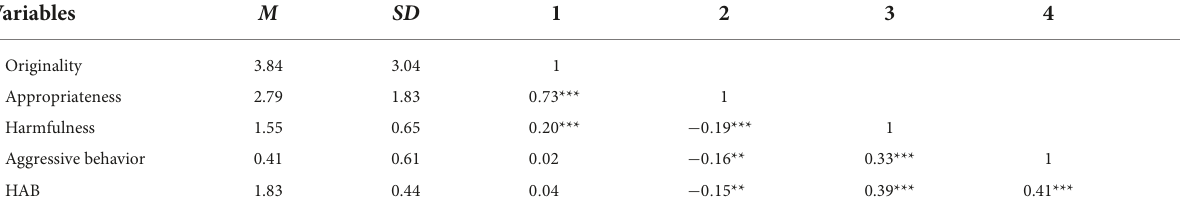
TABLE 1 Means, SD s, and